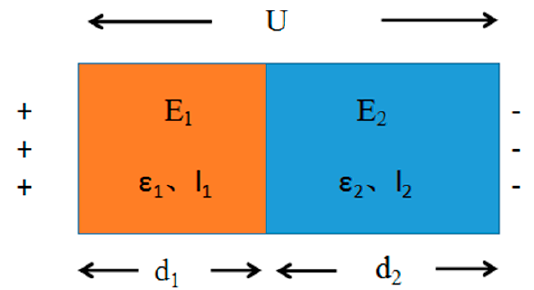
Figure 1. Diagram for Maxwell–Wagner polarization.